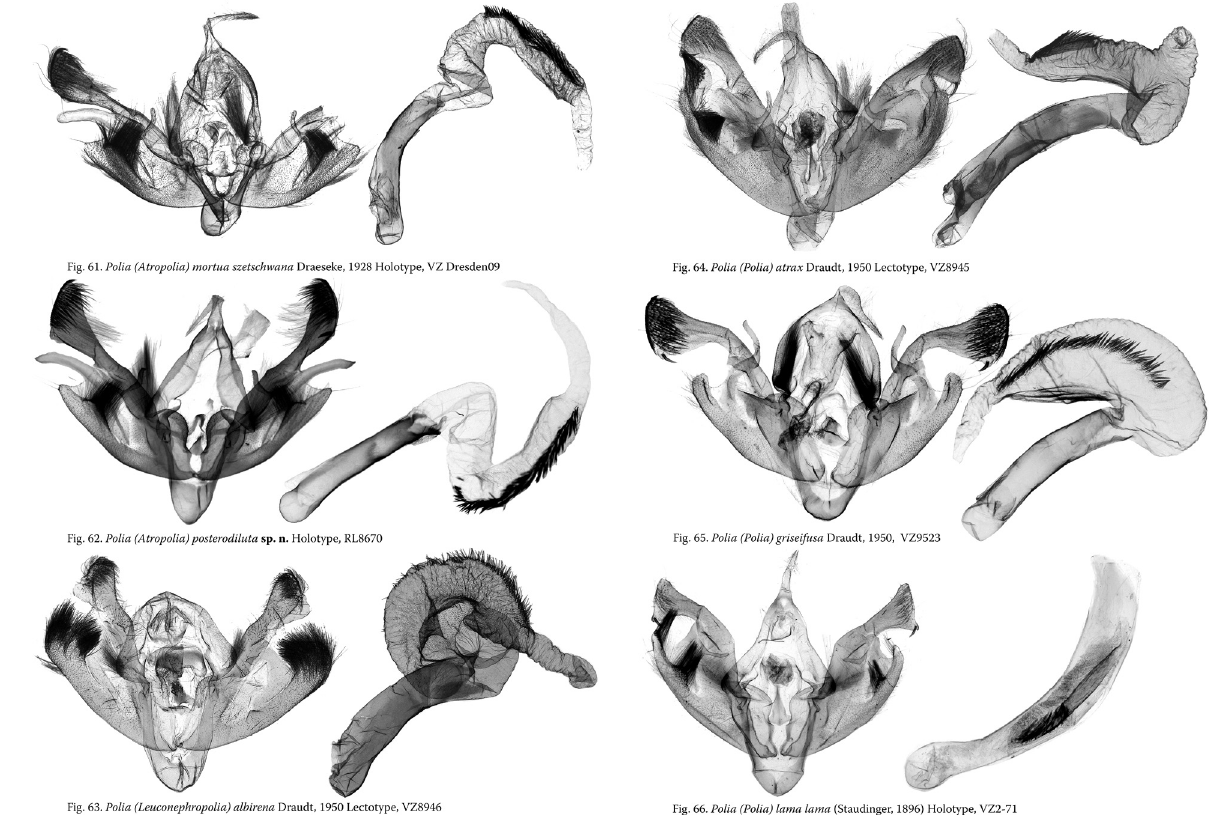
Figure 61–63. 61. Polia ( Atropolia ) mortua szetschwana Draeseke, 1928 Lectotype male. 62. Polia ( Atropolia ) postero- diluta sp. n. Holotype male. 63. Polia ( Leuconephropolia ) albi- rena Draudt, 1950 Lectotype male.